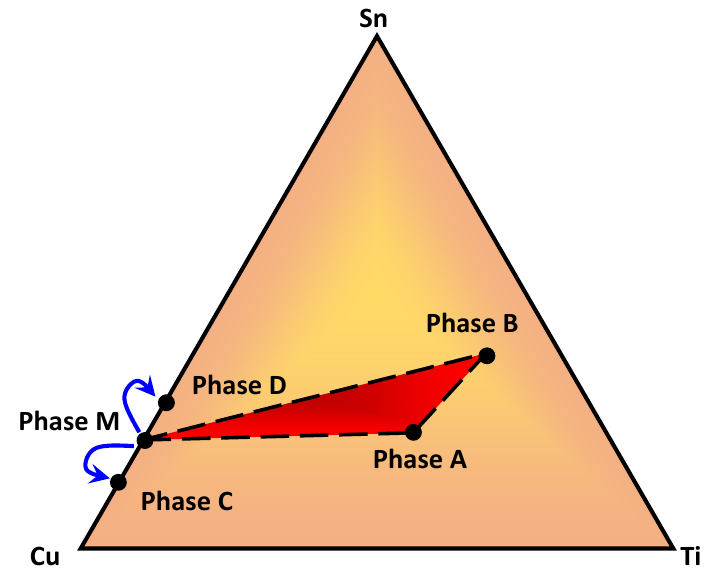
Figure 7. Phases A, B, C, D, and M in the ternary Cu–Sn–Ti phase diagram. The dashed triangle indicates a three-phase equilibrium of Cu–23Ti–17Sn at 900 °C. The arrows show phase separation occurs at temperatures below 900 °C.